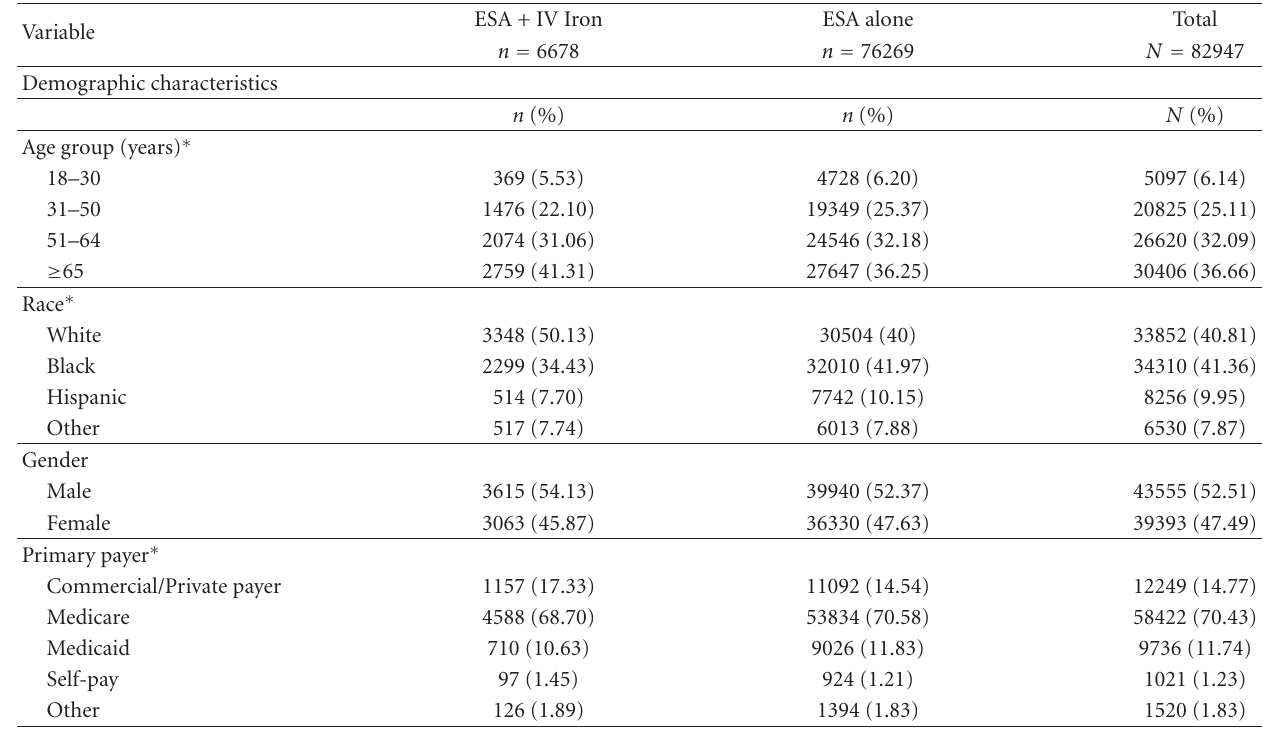
Table 3: Demographic characteristics of the study